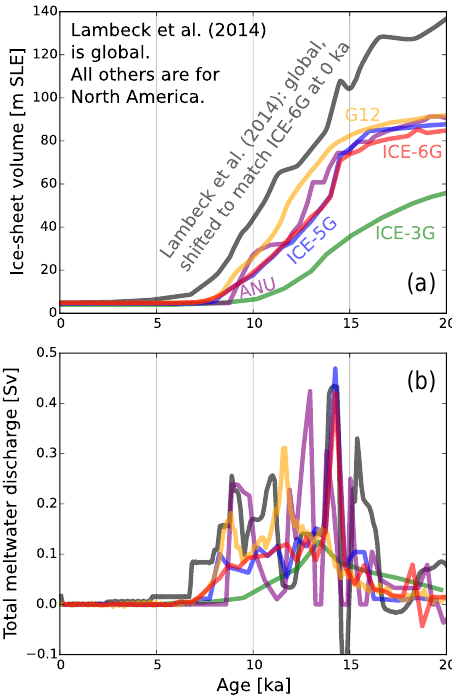
Figure 2. Ice volume and meltwater discharge histories over the North American computational region for each of the examined ice- sheet reconstructions (colors), along with changes in global ice vol- ume from Lambeck et al. (2014) (gray). (a) Cumulative change in ice volume over time. Volumes for the five ice-sheet reconstruc- tions evaluated here are summed over the computational domain, which contains the entire North American ice-sheet complex and part of Greenland. The Lambeck et al. (2014) ice-volume curve is global but has been shifted to match ICE-6G at the 0ka (i.e., modern) time step for easier comparison with the deglacial North American curves. These ice volumes are presented in meters sea- level equivalent (SLE), assuming a constant ocean surface area of 3.62 × 10 8 km 2 (after Marshall and Clarke, 1999). (b) Total melt- water discharge over the computational domain for each ice-sheet reconstruction. ICE-5G and ICE-6G have a noticeable peak during MWP-1A, 14.65–14.31ka (Deschamps et al., 2012). Though the timescale of their numerical model is shifted, Gregoire et al. (2012) also consider their meltwater peak, due to collapse of the ice sad- dle between the Cordilleran and Laurentide ice sheets, to represent MWP-1A. The global-scale Lambeck et al. (2014) sea-level curve includes a meltwater peak ∼ 16.5–15ka, which encompasses Hein- rich Event 1B (15.9–15.7ka) (Gil et al., 2015) and significant ice- sheet melt (12.4–6.7ka), during the first half of the Holocene. The vertical axis is in sverdrups, where 1Sv is 10 6 m 3 s − 1